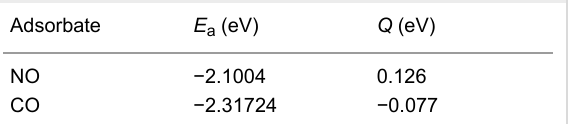
Table 1: Mulliken population and adsorption energy calculated for the adsorption of CO and NO molecules on the armchair graphene nanoribbon (AGNR).